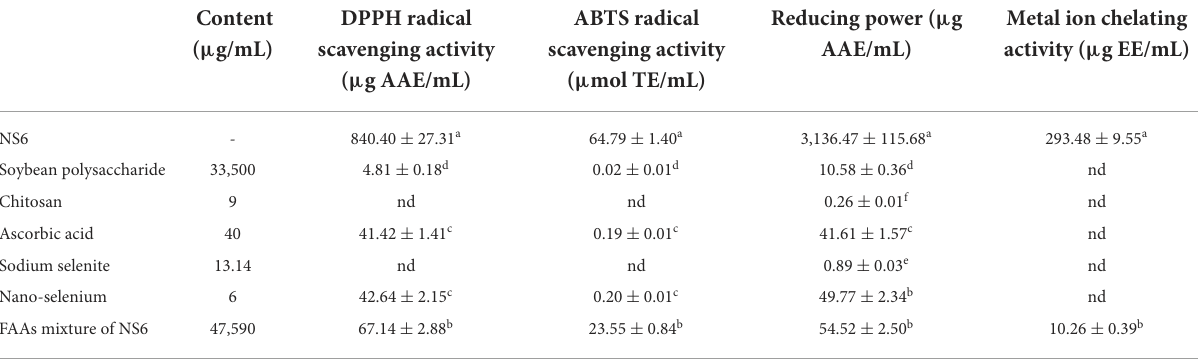
TABLE 4 Antioxidant activities of ingredients in NS6.